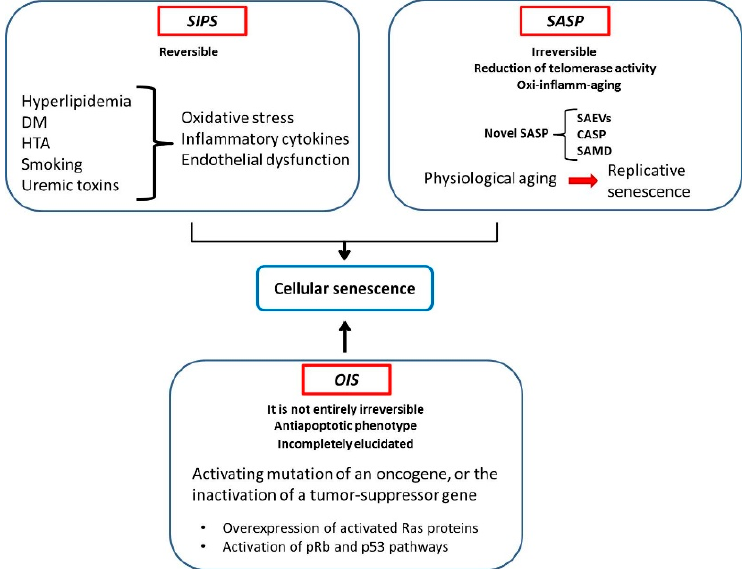
Figure 1. Types of senescence. Stress-induced premature senescence (SIPS), senescence-associated secretory phenotype (SASP) and, oncogene-induced senescence (OIS). Senescence-associated EVs (SAEVs); CKDs-associated secretory phenotype (CASP); senescence-associated mitochondrial dysfunction (SAMD).